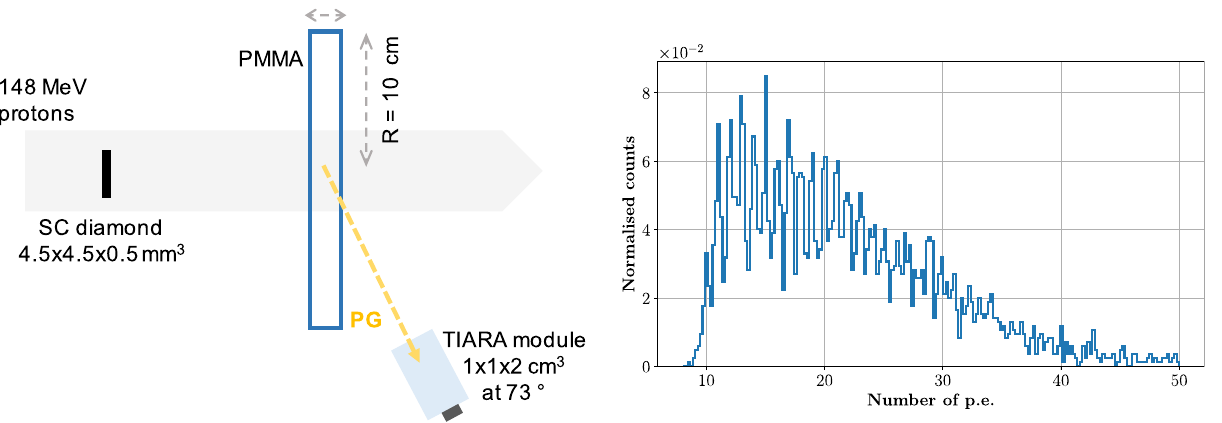
Figure 7. Left: experimental set-up for the CTR measurement carried out at the S2C2. A 5 mm thick, 10 cm radius PMMA target was used as a source of PGs to measure the CTR. Given the limited transit time of protons within the target, the PG source can be considered point-like. The beam size (4.3 mm σ ) was larger than the diamond surface (4.5 4.5 mm 2 ) as no collimator was employed. The TIARA detection module was composed × of a 2 cm 3 PbF 2 crystal coupled to a 6 6 mm 2 SiPM and placed at approximately 73 ◦ from the beam direction. × The effective beam intensity at the beam monitor level was 0.78 p/bunch. Right: energy deposited in the TIARA detection module expressed as the integral of the SiPM signal. A threshold of 10 p.e. was applied for data acquisition, resulting in a median number of 21 p.e. detected. The energy response of the module is shown in Fig. 7, right: a median number of 21 p.e. is detected per each PG event when applying an acquisition threshold of 100 mV ( 10 p.e.). This improvement, with respect to the ∼ median value of 7 p.e. obtained in the previous experiment (Fig. 2, left) is mainly due to the increased size of the SiPM that allows collecting a larger number of Cherenkov photons per PG event. The difference between the PG detector time stamp (obtained with a 5% CF threshold) and the diamond time stamp (obtained with a 50% CF threshold) was calculated to build the TOF distribution for the 5 mm target irradiation shown in Fig. 8. This distribution presents two clear components: (i) a well resolved gaussian peak (highlighted by the orange fit) that corresponds to PG events generated by protons crossing the diamond detector, and (ii) a broad background (highlighted by the green fit) associated to PG events from protons passing by the beam monitor. The first peak directly provides a measurement of the system CTR with a value of 397 ps (FWHM). This CTR can also be interpreted as the quadratic sum of the diamond and the PG detector time resolutions. In a previous experiment, the intrinsic time resolution of the diamond was measured to be 360 ps (FWHM) when reading-out a single face of the detector. Under these conditions, the diamond time resolution is expected to be overestimated by 50–70 ps (FWHM) with respect to experiments in which signals from both sides are summed-up for analysis 25 . Despite the measured time resolution can not be directly compared to the CTR measured in this work, it still appears obvious that, for 148 MeV, the system CTR is now dominated by the beam monitor, with the TIARA detection module contributing for less than 167 ps (FWHM). This effect is expected, as an increase in the proton